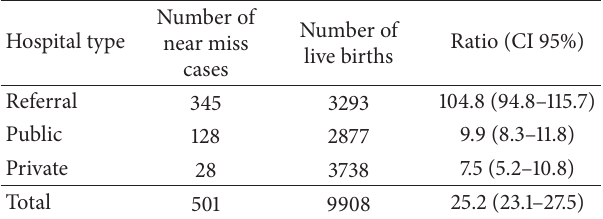
Table 1: Maternal near miss ratio according to hospital